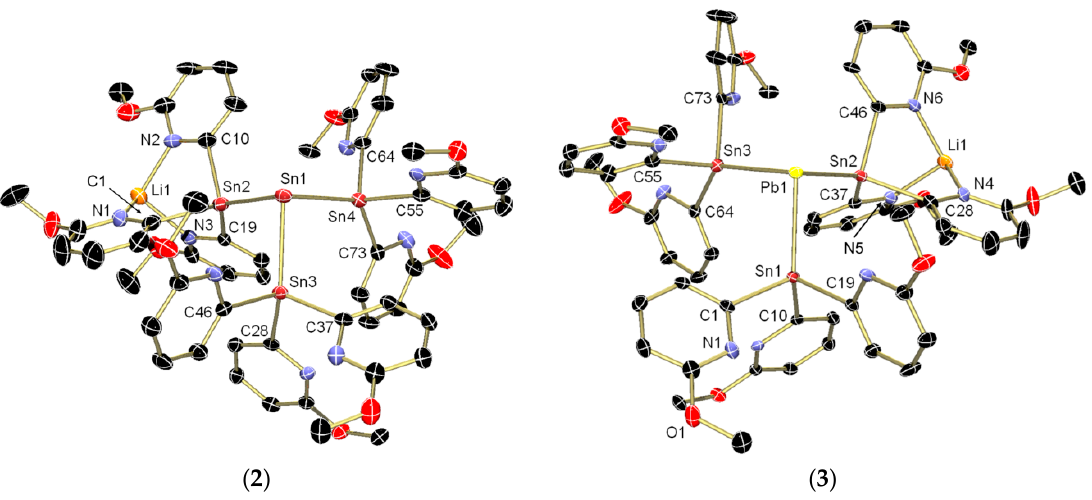
Figure 1. Molecular structures of [LiSn{Sn(2-py 6O t Bu ) 3 } 3 ] ( 2 ) and [LiPb{Sn(2-py 6O t Bu ) 3 } 3 ] ( 3 ) with 30% probability ellipsoids. Hydrogen atoms and methyl groups are omitted for clarity. Table 1. Selected bond lengths (Å) and bond angles (°) of compounds 2 and 3 .